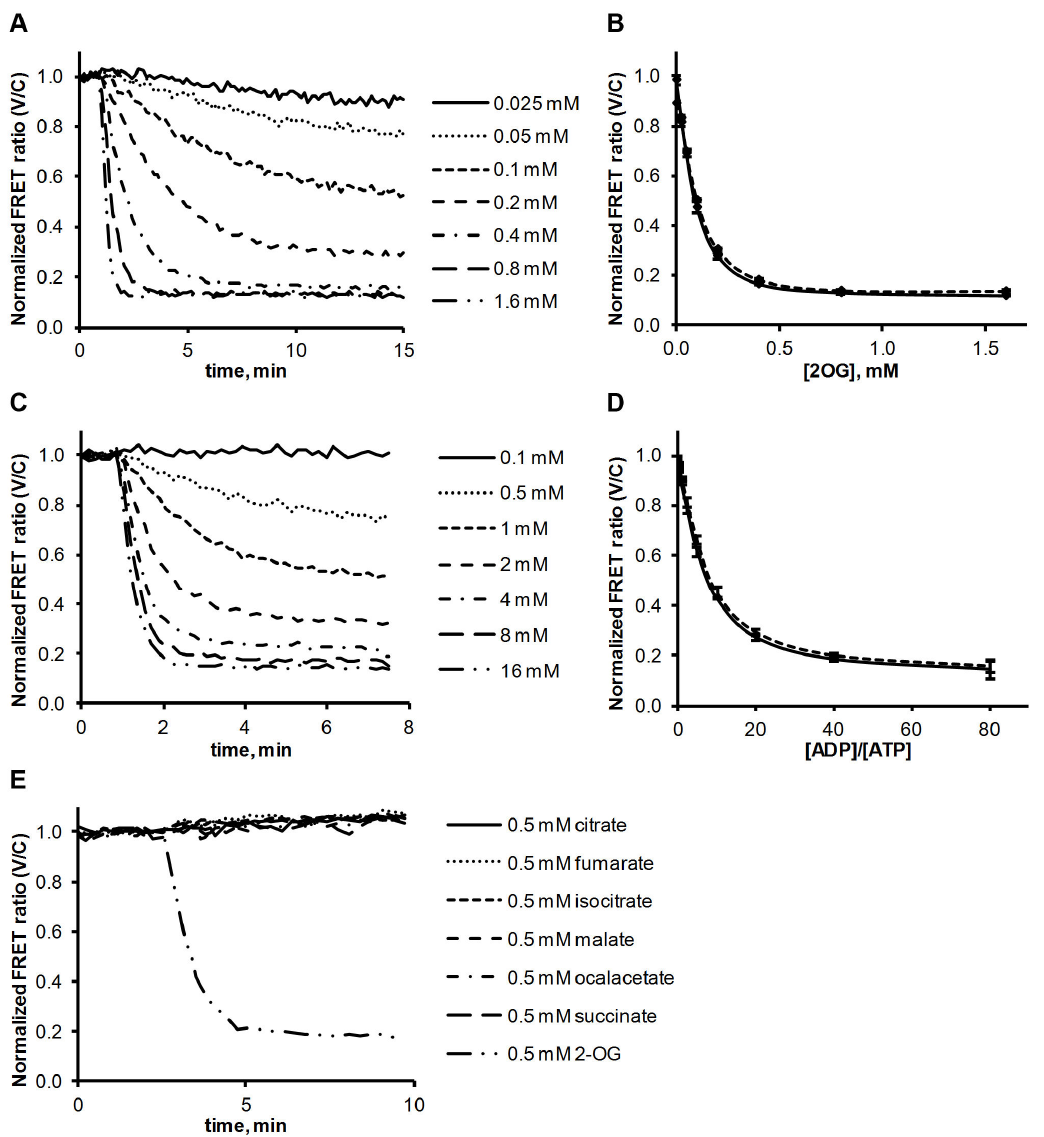
Figure 4. Influence of effector molecules on the P - NAGK complex. ( A ) 2-OG induced dissociation of the NAGK ‑ FL25 ‑ C + II P -ST ‑ V complex, as determined by FRET analysis. The FRET ratio (525 nm / 475 nm emission) is background subtracted and II normalized to first 6 values. ( B ) End point measurements of 2-OG induced dissociation. Solid line: NAGK ‑ FL25 ‑ C and P -ST ‑ V were II incubated together for 10 min and then 2-OG was added. After 30 min of incubation the FRET ratio was determined. Dashed line: NAGK ‑ FL25 ‑ C and P -ST ‑ V were coincubated with 2-OG for 30 min without preincubation and then the FRET ratio was determined. II All signals were normalized to values from control experiments without 2-OG. All reactions were performed as triplicates; standard deviation is indicated by error bars. ( C ) ADP-induced dissociation of the NAGK ‑ FL25 ‑ C + P -ST ‑ V complex, as determined by FRET II analysis. Background subtracted and normalized to first 6 values. 0.1 mM ATP was present in the reaction mix. ( D ) End point measurements of ADP induced dissociation. Solid line: NAGK ‑ FL25 ‑ C and P -ST ‑ V were incubated together for 10 min and then II ADP was added. After 30 min of incubation the FRET ratio was determined. Dashed line: NAGK ‑ FL25 ‑ C and P -ST ‑ V were II coincubated with ADP for 30 min without preincubation and then the FRET ratio was determined. 0.1 mM ATP was present in the reaction mix, ADP concentrations were ranging from 0.25 to 8 mM. Inset: Magnification showing FRET signals from NAGK ‑ FL25 ‑ C and P -ST ‑ V in the presence of 2 mM ATP and ADP concentrations ranging from 0.5 to 2 mM (dotted line) representing more II physiological concentrations. All signals were normalized to values from control experiments without ADP. All reactions were performed as triplicates; standard deviation is indicated by error bars. ( E ) Dissociation of NAGK ‑ FL25 ‑ C and P -ST ‑ V complex with II 0.5 mM of malate, fumurate, succinate, oxalacetate, citrate, isocitrate and 2-OG. 0.075 mM ATP was present in all reactions. doi: 10.1371/journal.pone.0083181.g004 PLOS ONE |